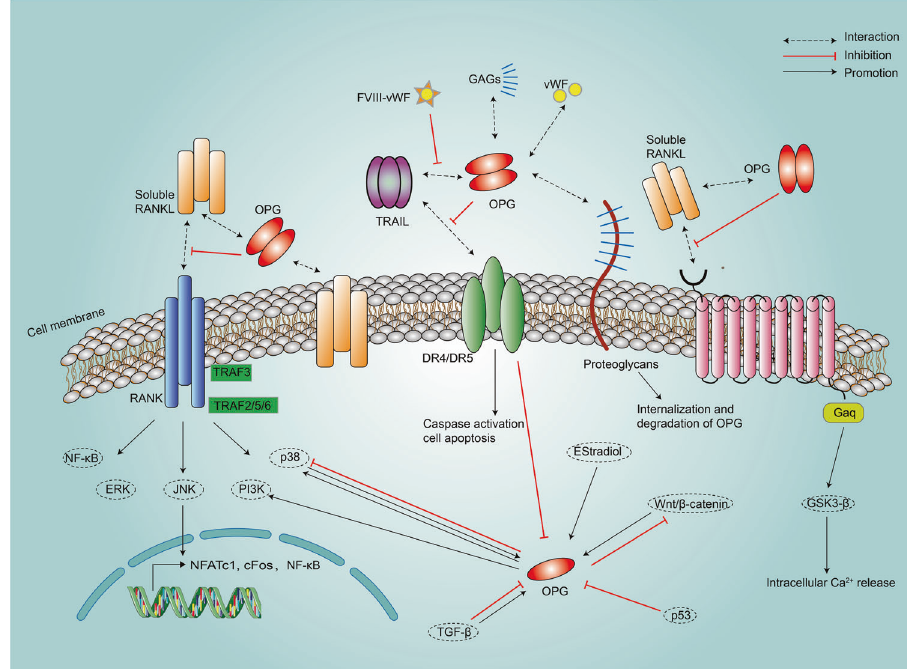
Fig. 2 OPG-related signaling pathways. OPG is secreted in a homodimeric form. By binding with RANKL and TRAIL, OPG exerts its inhibitory effects on their downstream signaling pathways. Besides, OPG itself is regulated by many signaling pathway. Imbalanced signaling cross-talks between PI3K/AKT, p38/MAPK, wnt/ β -catenin, TGF- β , mTOR and OPG contribute to the pathological cell behaviors. Other ligands, such as E2, vWF, FVIII-vWF and glycosaminoglycans (GAGs), bind with secreted OPG to impede its function. DR death receptor. and seven functional domains. After proteolytic cleavage of the signal peptide and homodimerization, the mature form of OPG is secreted from the cytoplasm to the extracellular compartment [2] (Fig. 1).